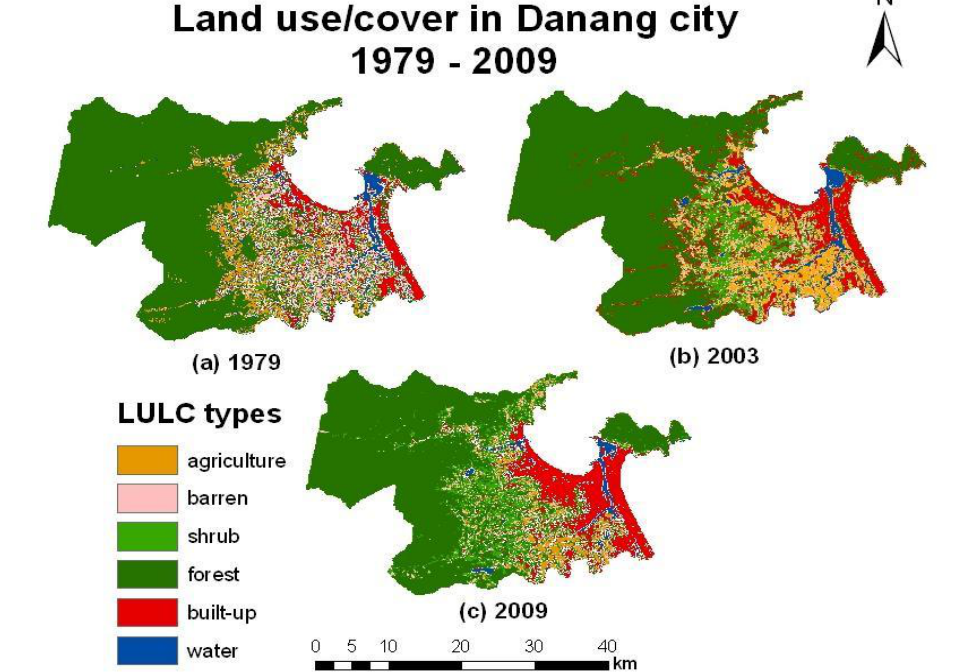
Figure 3. Land use/cover maps of Danang city